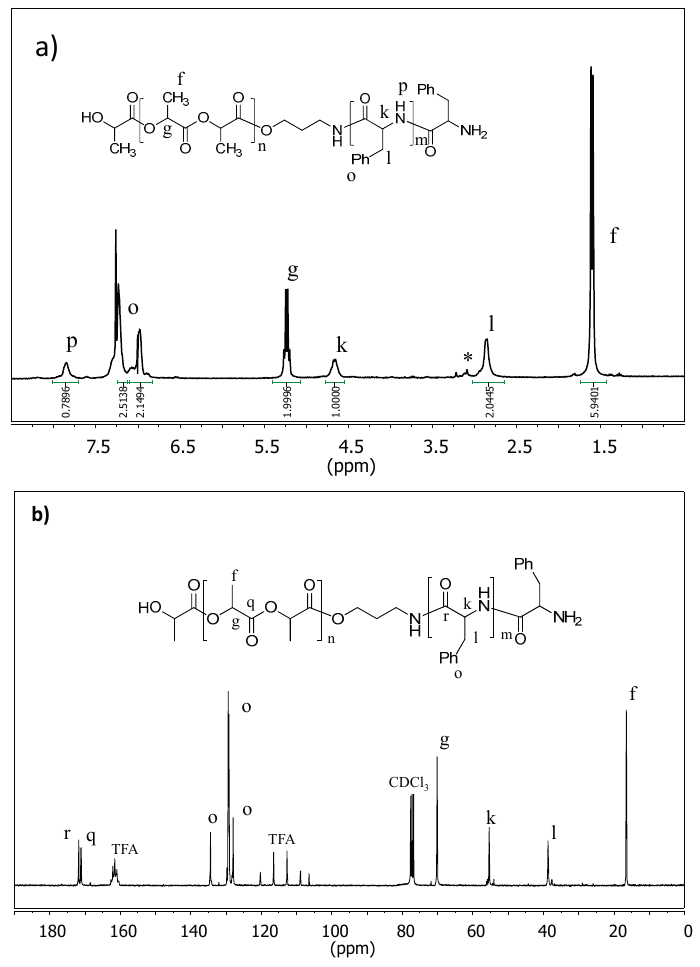
Figure 7. MALDI-TOF-MS spectra of PLLA